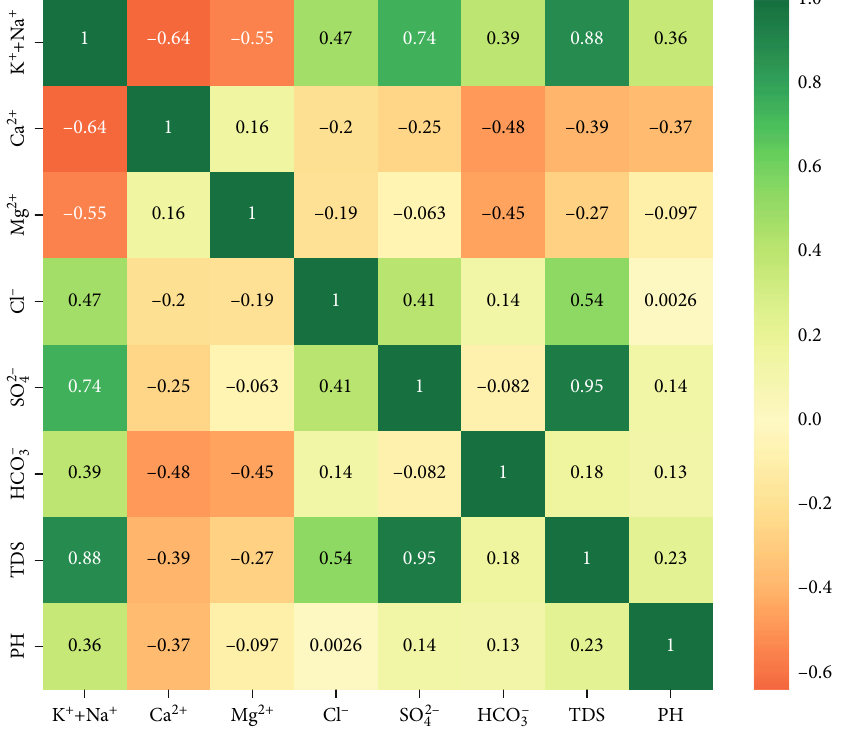
Figure 5: Heat map of the correlation coe ffi cient for each